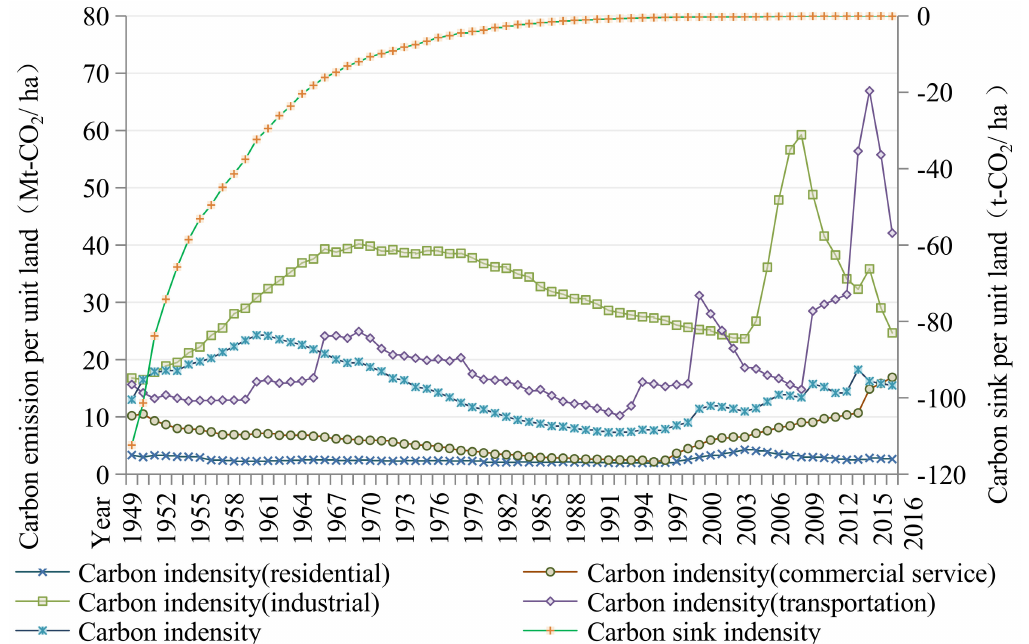
Figure 10. Carbon emission and carbon sink intensity per unit of land use.